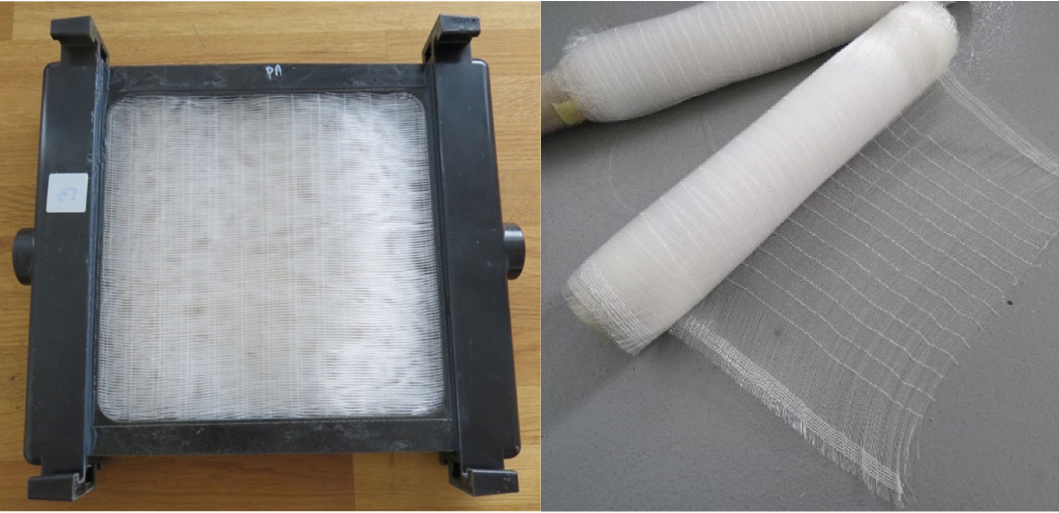
Figure 1. Tested heat exchanger made of polypropylene fiber fabric ( left ) and woven heat transfer surface with separated fibers ( right